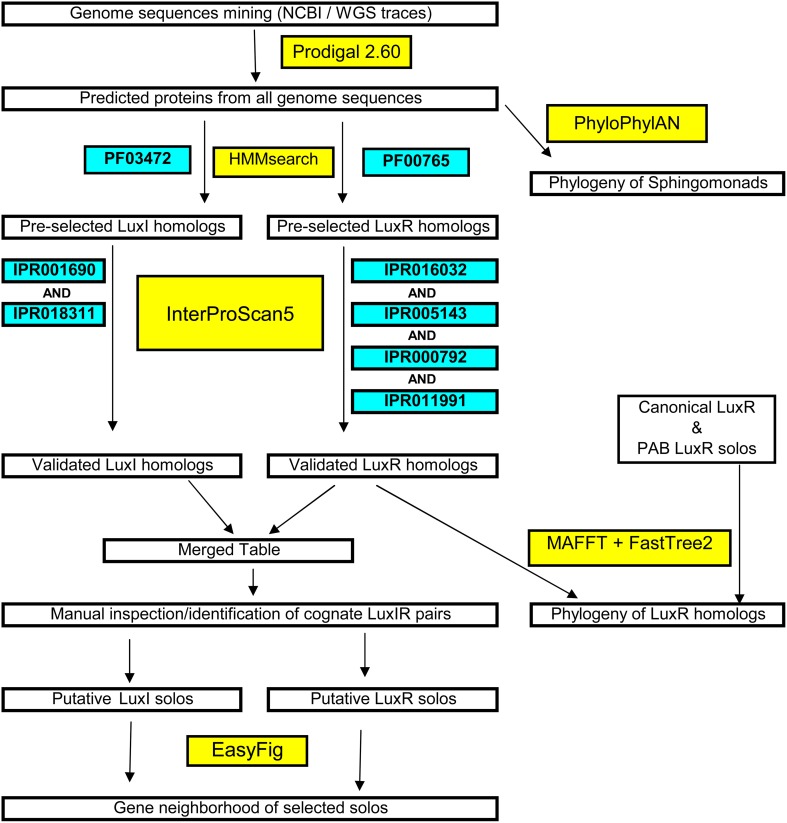
Flowchart of the systematic and stringent bioinformatics methodology used in this study for the identification of luxI/R in sphingomonads and large-scale phylogenetic/phylogenomic tree construction.